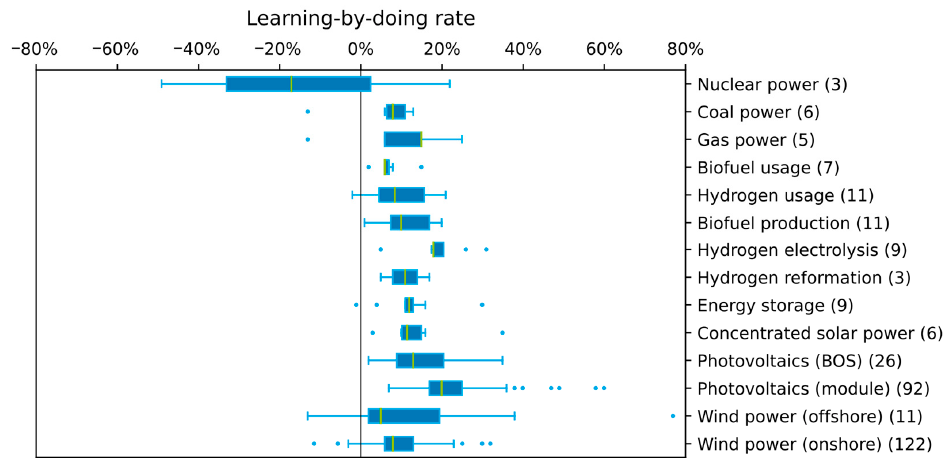
Figure 2. Statistical box plot showing the distribution of LBD rates uncovered by our literature review. Green lines show the median ( Q 2 ) and surrounding blue boxes the interquartile range (IQR = Q 3 − Q 1 ), where Q n refers to the n ’th quartile. The remaining data are classified as regular data or outliers, depending on whether they are within [ Q 1 − 1.5 · IQR, Q 3 + 1.5 · IQR ] . The distribution of the remaining regular data is shown as whiskers and the outliers are shown as blue dots. See Appendix C for a tabular listing of the data and references used for this